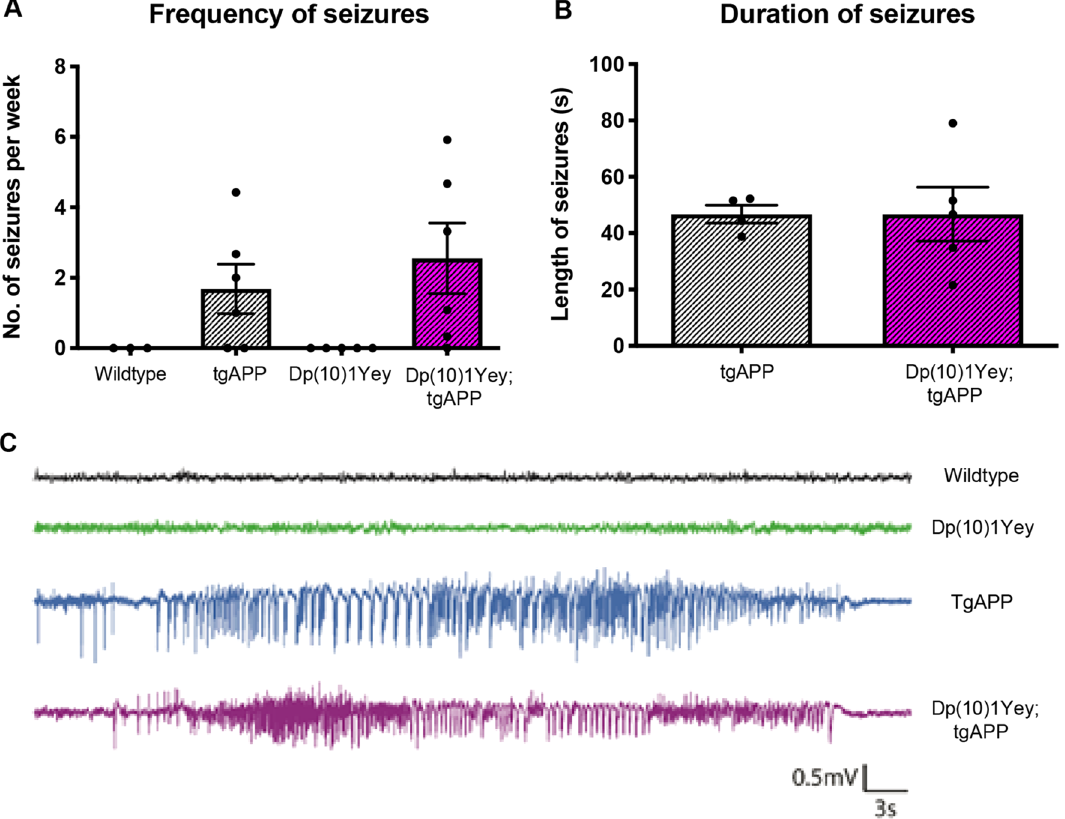
Figure 6. The Dp(10)1Yey segmental duplication did not alter the frequency or duration of APP transgene- associated seizures. ( A ) The frequency and ( B ) duration of seizure-like events was measured in male mice by cortical EEG using implanted electrodes in freely moving mice in the home cage. ( A ) The frequency (T-test p = 0.60, tgAPP n = 6, Dp(10)1Yey;tgAPP n = 6 all male) and ( B ) duration (T-test p = 0.64, tgAPP n = 6, Dp(10)1Yey;tgAPP n = 6) of seizure-like events was not altered by the duplication of the Dp(10)1Yey region. ( C ) Example EEG trace of a seizure-like event in tgAPP and Dp10;tgAPP animals with control time-matched wildtype and Dp(10)1Yey littermates traces for comparison. Error bars show SEM, data points are independent